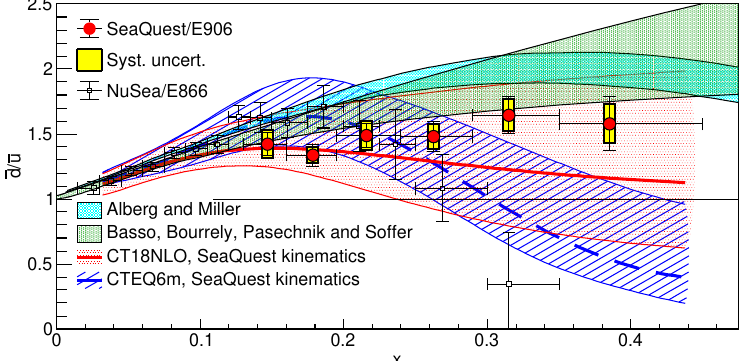
Figure 2: Ratios of ¯d ( x ) to ¯u ( x ) . Ratios of ¯ d ( x ) to ¯ u ( x ) in the proton (red filled circles) with their Figure 3: Antiquark flavor asymmetry ¯ d / ¯ u as a function of Bjorken x [ 7 ] . The red statistical (vertical bars) and systematic (yellow boxes) uncertainties extracted from the present points with yellow bands show the SeaQuest results with the systematic uncertainty. data based on next-to-leading order calculations of the Drell-Yan cross sections. Also shown in the open black squares are the results obtained by the NuSea experiment with statistical and systematic The rectangle blank points are the results by E866. The meson cloud model pre- uncertainties added in quadrature 11 . The cyan band shows the predictions of the meson-baryon diction (Alberg and Miller, light blue band), the statistical model prediction (Basso, model of Alberg and Miller 23 and the green band shows the predictions of the statistical parton Bourrely, Pasechnik and Soffer, green band), and calculations of CT18NLO (red band) distributions of Basso, Bourrely, Pasechnik and Soffer 19 . The red solid (blue dashed) curves show the calculated ratios of ¯ d ( x ) to ¯ u ( x ) with CT18 27 (CTEQ6 34 ) parton distributions at the scales of and CTEQ6m (blue band) are drawn the SeaQuest results. The horizontal bars on the data points indicate the width of the bins.